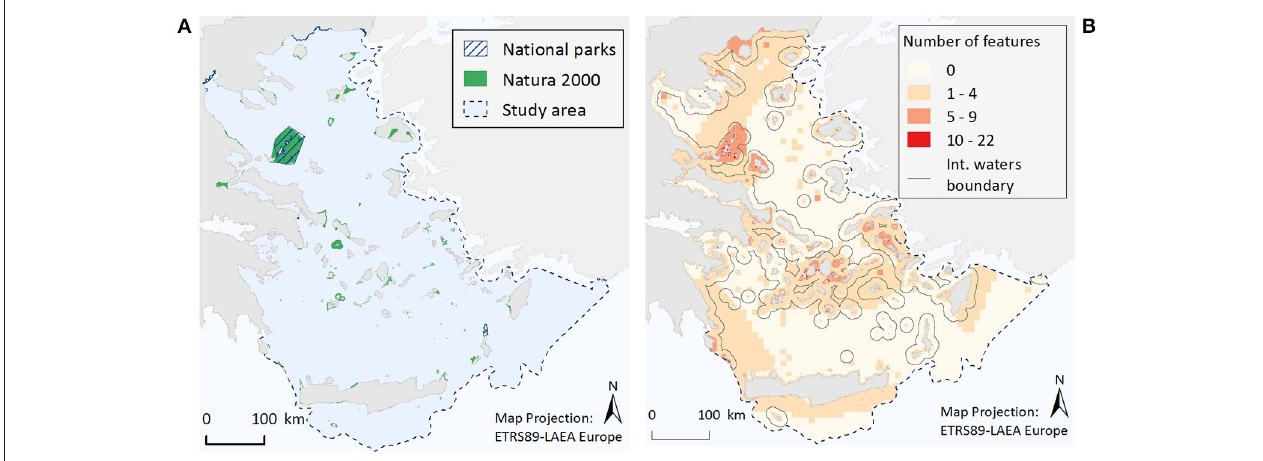
FIGURE 4 | Illustrative maps depicting (A) National Parks and Natura 2000 sites, and (B) the number of ecological features found in different parts of the study